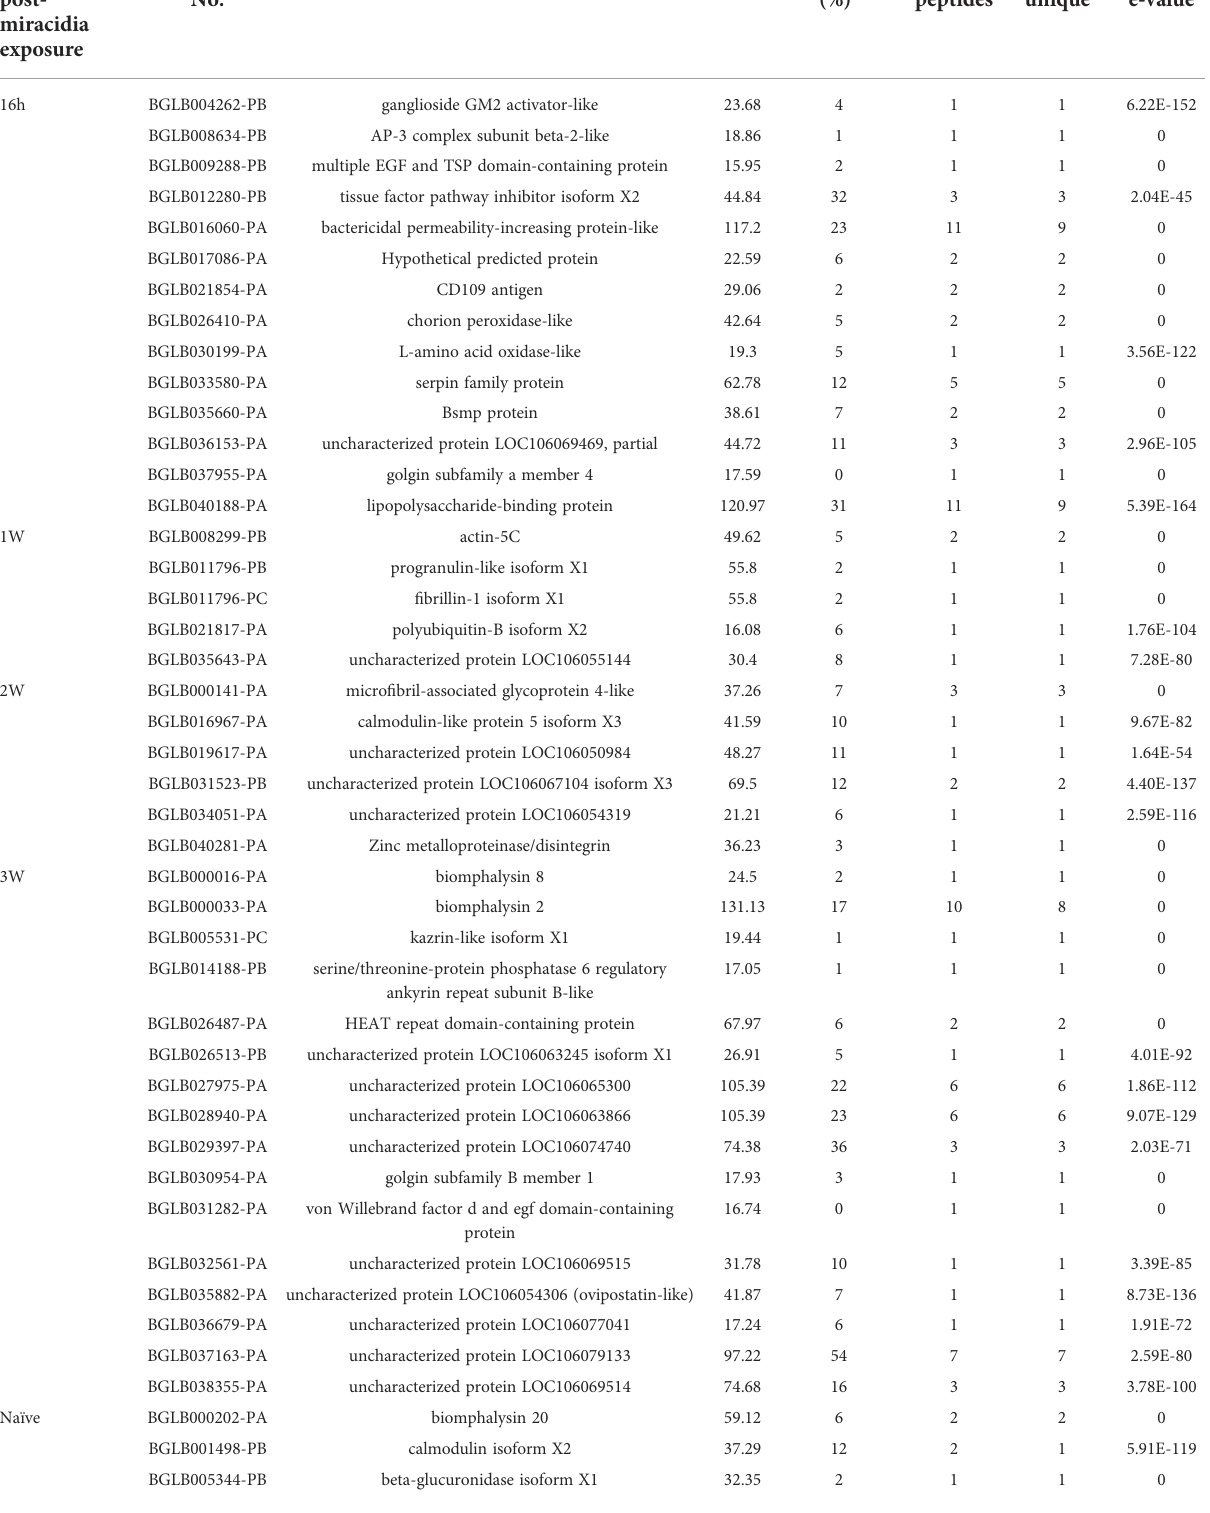
TABLE 2 Non-redundant ESPs, identi fi ed with con fi dence, exclusive to B. glabrata SCW from snails that were naïve and at 16h-, 1W-, 2W- and 3W-PME to S. mansoni miracidia. Time-point post-